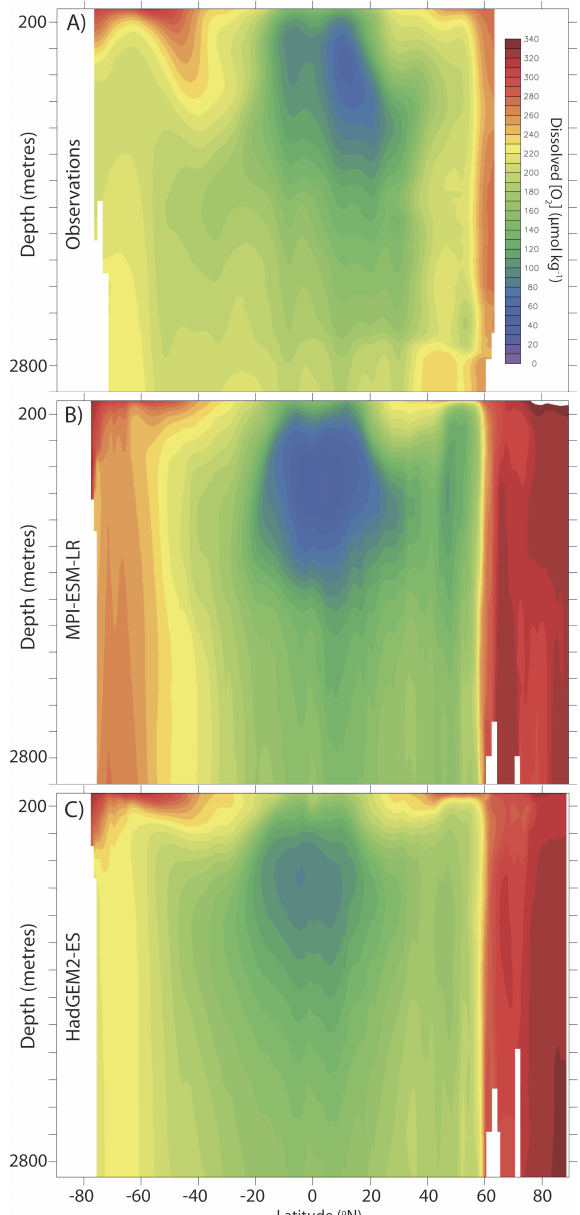
Fig. 2. Zonal mean [O 2 ] distribution (µmolkg − 1 ) for ∼ 1992 as a function of latitude and depth from (A) observations (Helm et al., 2011), and historical integrations of (B) MPI-ESM-LR and (C) HadGEM2-ES.